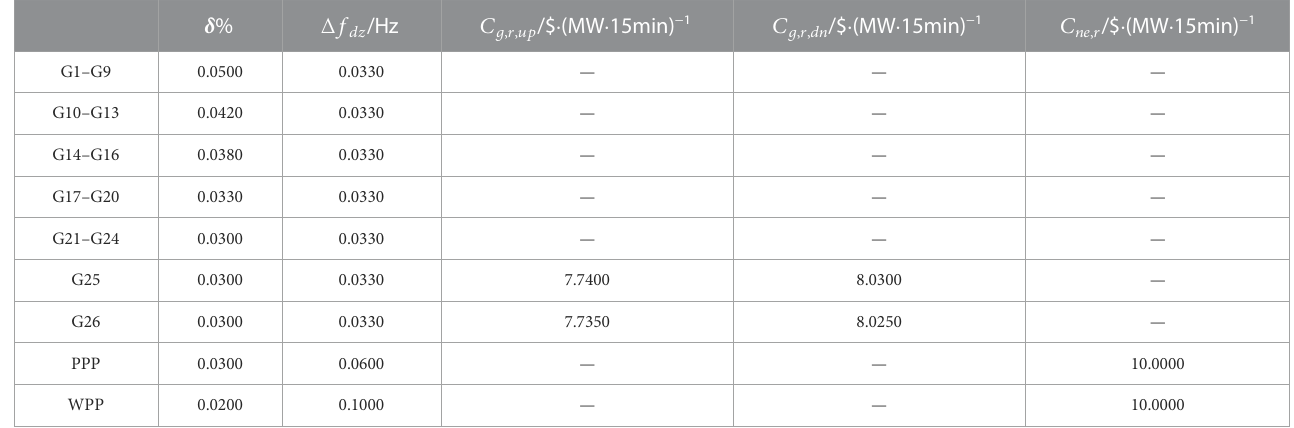
TABLE 2 parameters of frequency regulation.